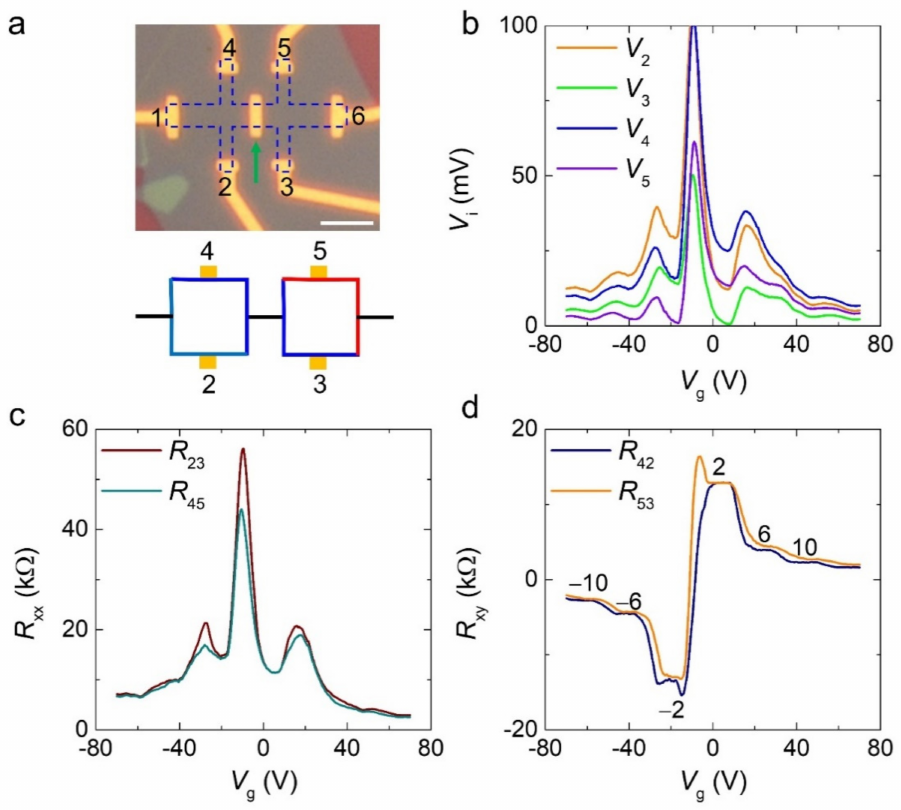
Figure 4. Quantum Hall (QH) state of the controlled device with an additional electrode placed at the middle of the Hall bar structure device. ( a ) Optical microscopy image of the device (top) and chemical potential line of the device in the presence of magnetic field (14 T) at low temperature (2 K). A blue dashed line denotes the graphene channel, and a green arrow indicates the additional metal bar. The scale bar is 5 µ m. ( b ) Gate voltage ( V g ) dependence of each voltage probe. ( c , d ) V g dependence of R xx and R xy , respectively. The data were measured at 14 T and 2 K with an applied current I ds = 1 µ